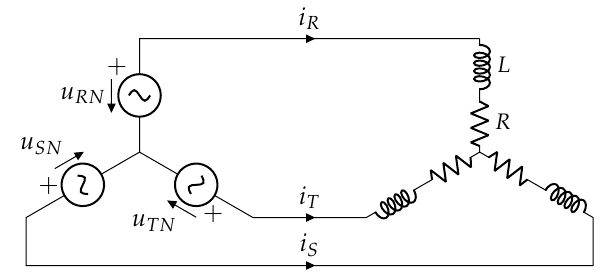
Figure 2. Symmetrical three-phase, three-wire